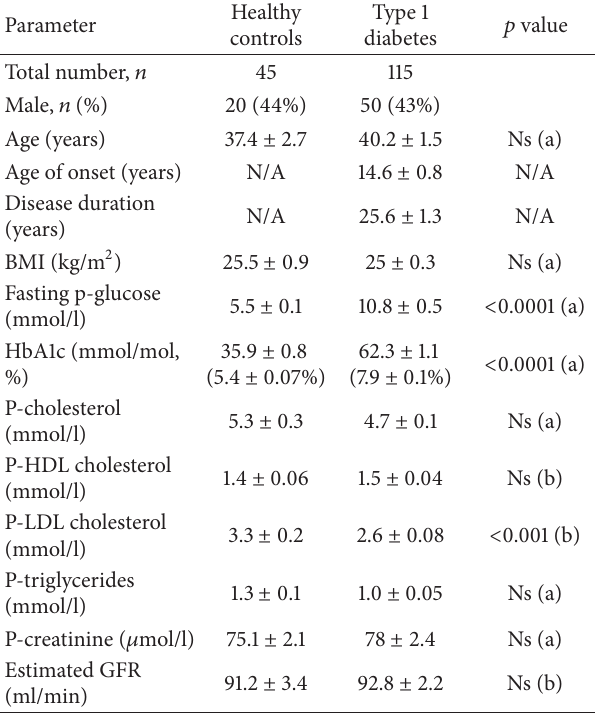
Table 1: Descriptive data for all study participants. The healthy controls and patients with type 1 diabetes (T1D) were matched regarding age, gender distribution, and BMI. The fasting levels of plasma glucose and HbA1c were, as expected, increased in the T1D patients. All values are given as mean ± SEM. An unpaired two- tailed 𝑡 -test based on ranks (Mann–Whitney) was used to compare differences between the two groups for data that were not normally distributed (a) and a two-tailed unpaired student’s 𝑡 -test was used for normally distributed data